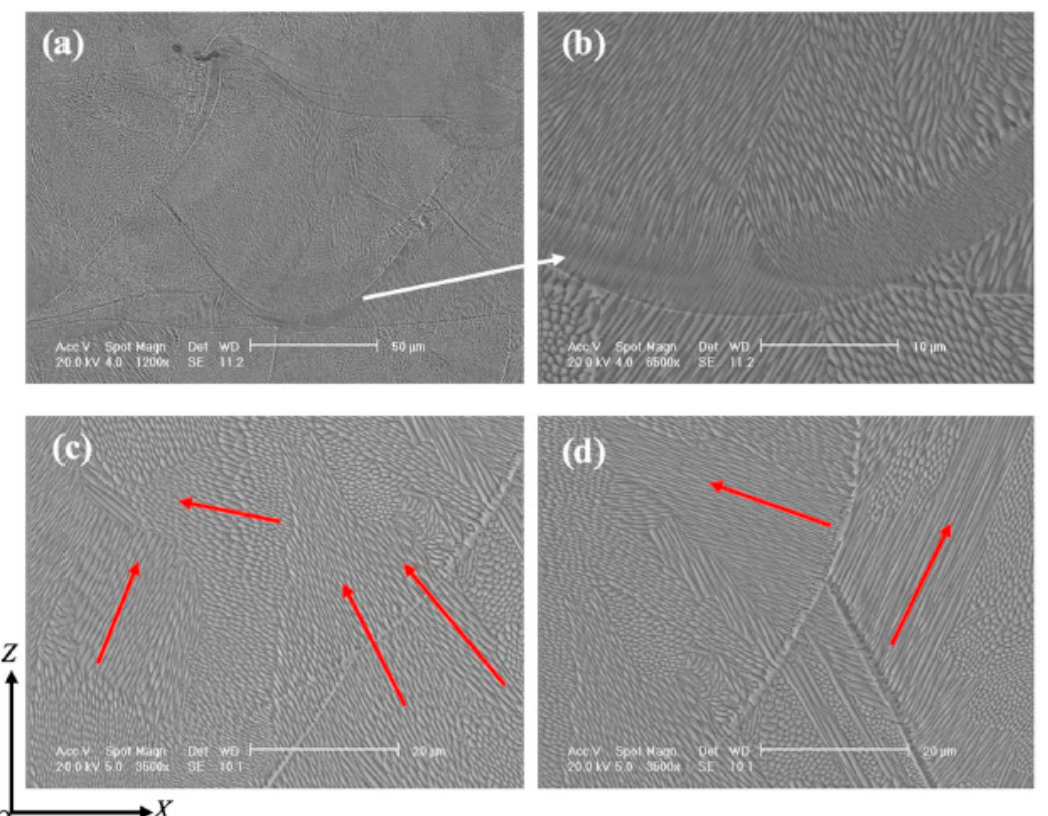
Figure 12. SEM micrographs showing the microstructure of 316L samples (laser power at 200 W): ( a ) within a weld bead; ( b ) at the bottom region of ( a ); ( c ) grain structure beyond two layers; ( d ) grains in two adjacent weld beads. Red arrows point out grain growth direction. Z specifies the building direction [134].